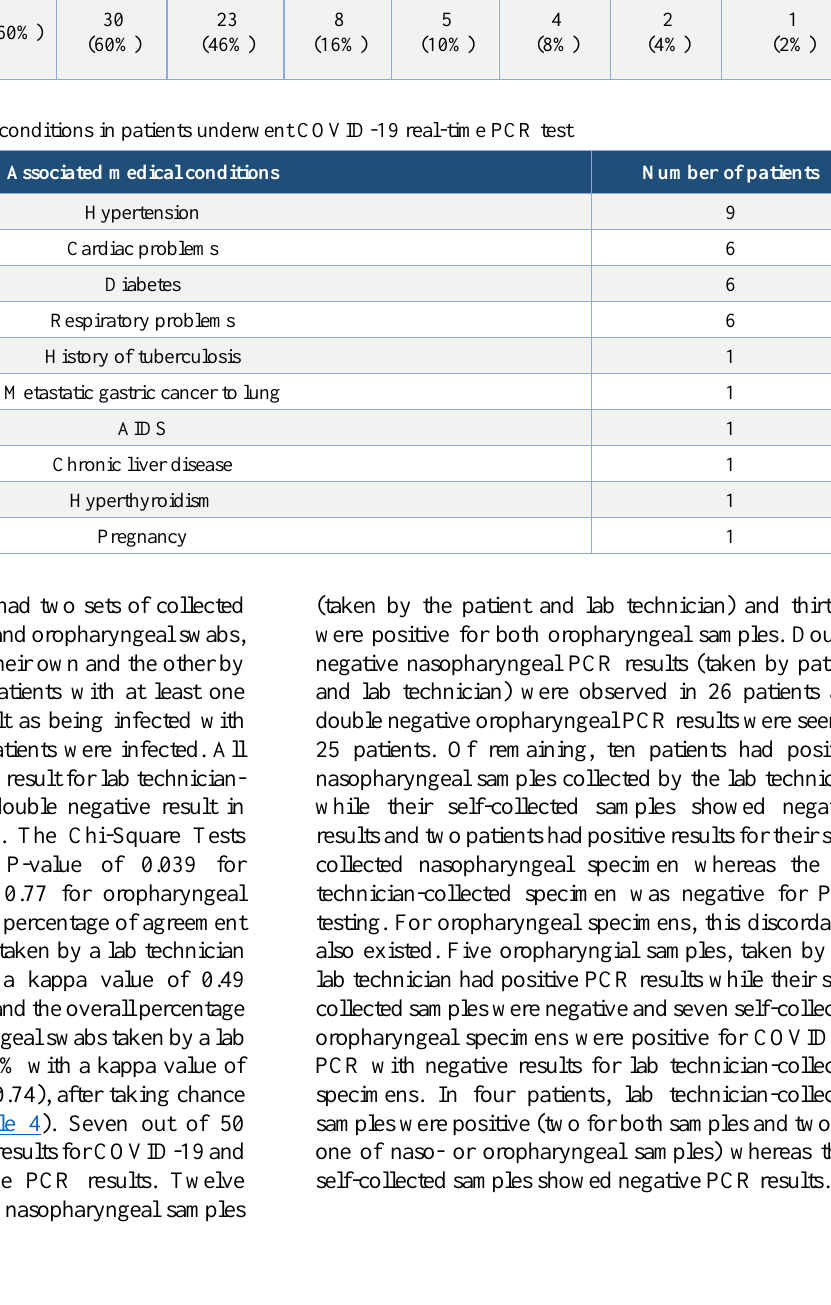
Table 1. Chief complaint of the patients suspected for COVID-19 Clinical symptoms